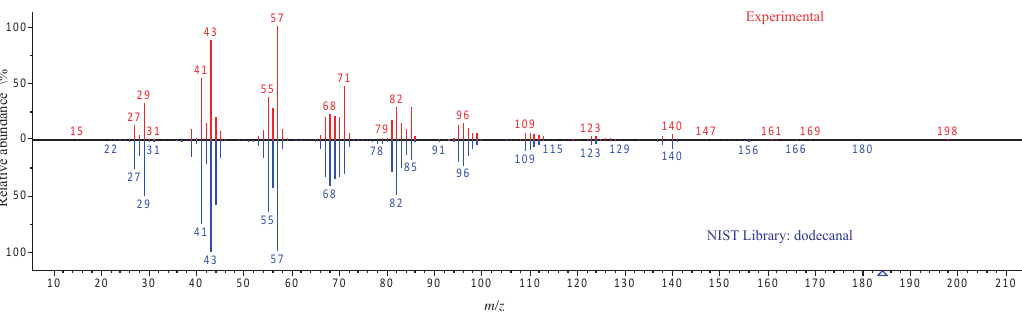
Huile1+PE p20k 650 gc5k s100 1.qgd Figure 8. Comparison between the experimental MS spectrum of molecule A, eluting at 63 min during the Py-GC/MS analysis of a mixture of LDPE and used oil, and the spectrum of dodecanal as found in the NIST